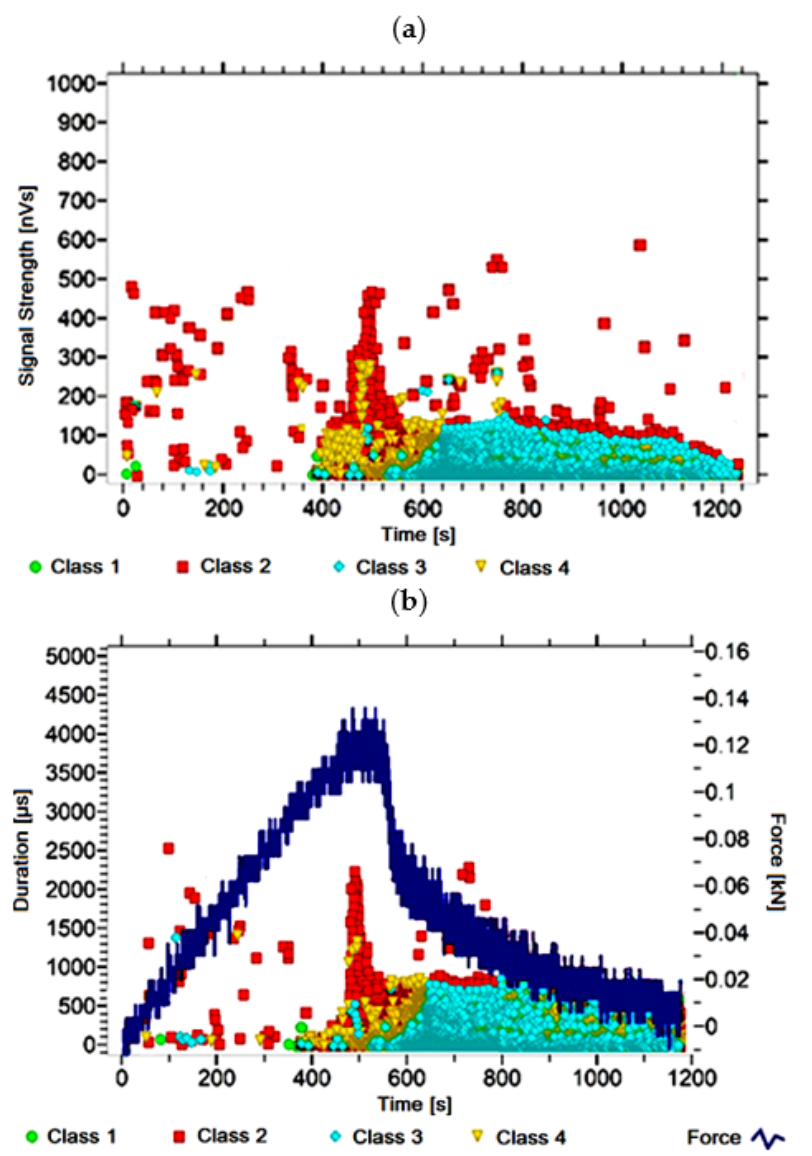
Figure 11. Graphs of acoustic emission signals for an exemplary sample of A 10 series: ( a ) signal strength over time; ( b ) distribution of the duration of the signals over time with the force increment curve.